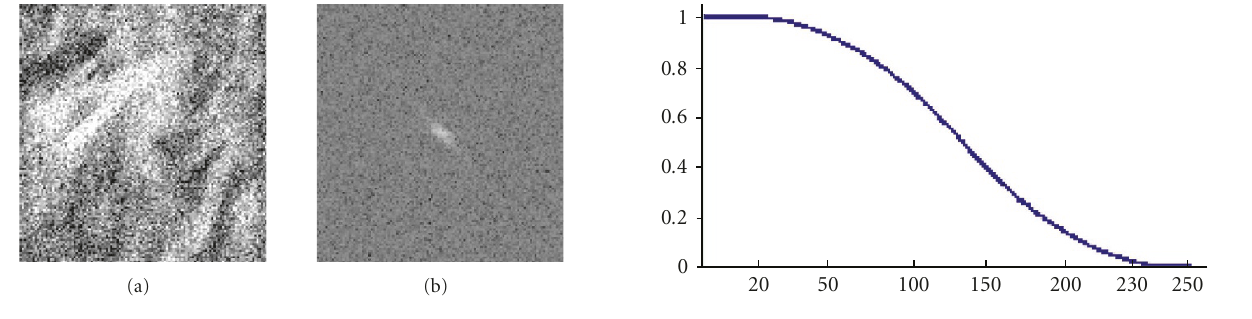
Figure 6: The Z -structure of membership function introduced by (15) when a = 20 and c =